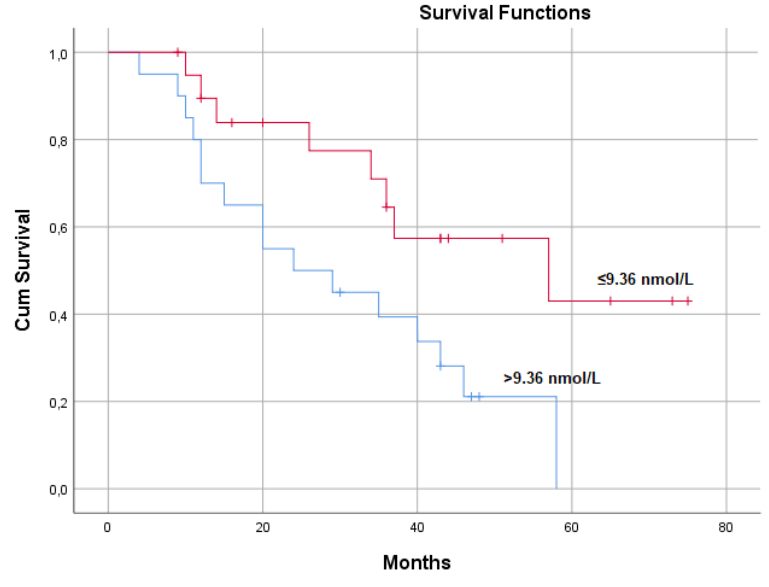
Figure 2: The survival rates with Kaplan-Meier plot for levels of